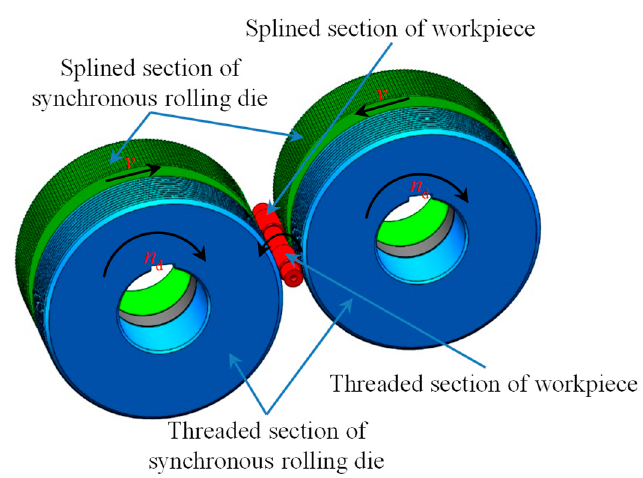
Figure 2. Synchronous rolling process with two round dies.